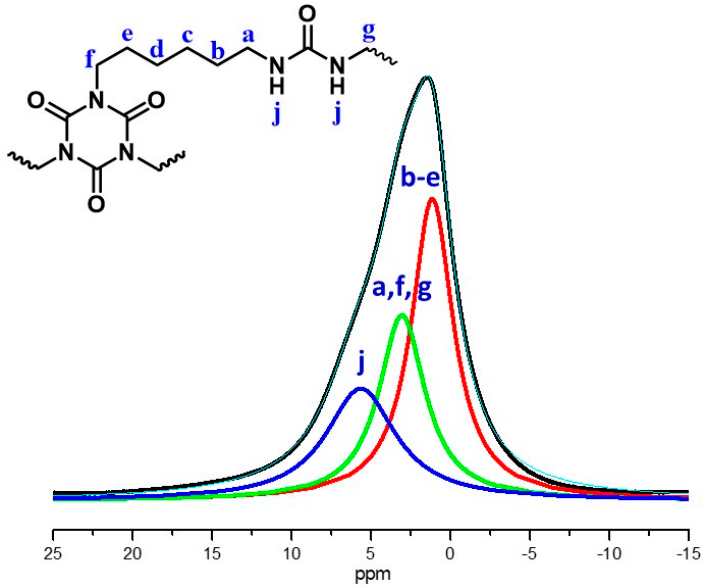
Figure 7. 1 H magic angle spinning (MAS) NMR spectrum of spherical PUA aerogel beads. Experimental spectrum (black line), fitted peaks (blue, green and red lines) and total fit (cyan line).